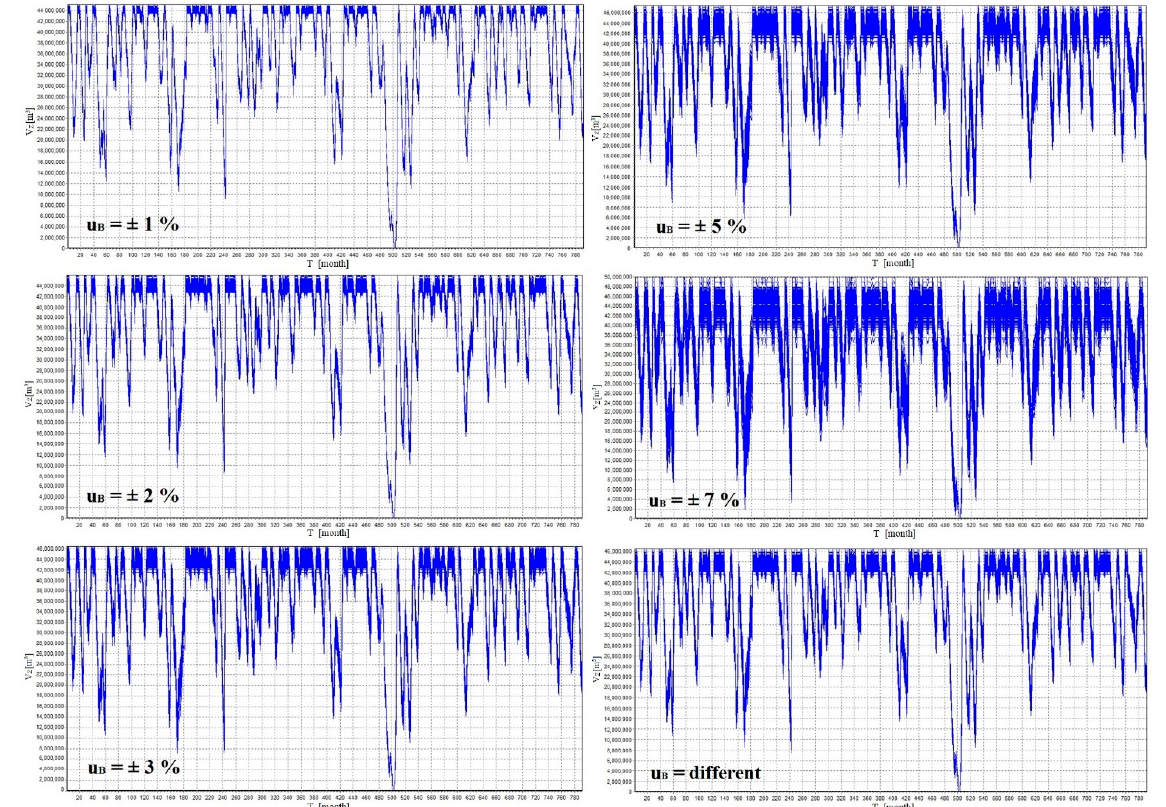
Figure 5. Courses of filling and emptying of the optimized V Z of the tested reservoir for constant u B = ± 1, ± 2, ± 3, ± 5 and ± 7% and for different u B . Table 3. Results of the analysis of optimal storage volumes V Z of the tested reservoir.